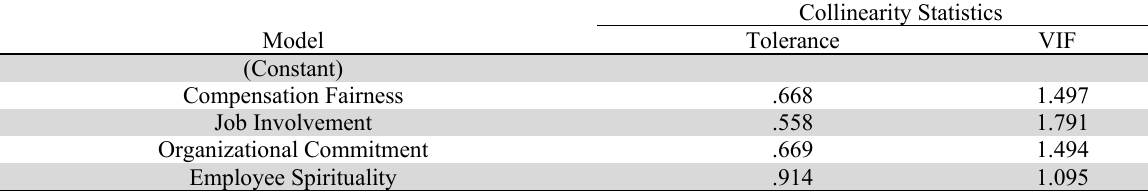
Multicollinearity Test